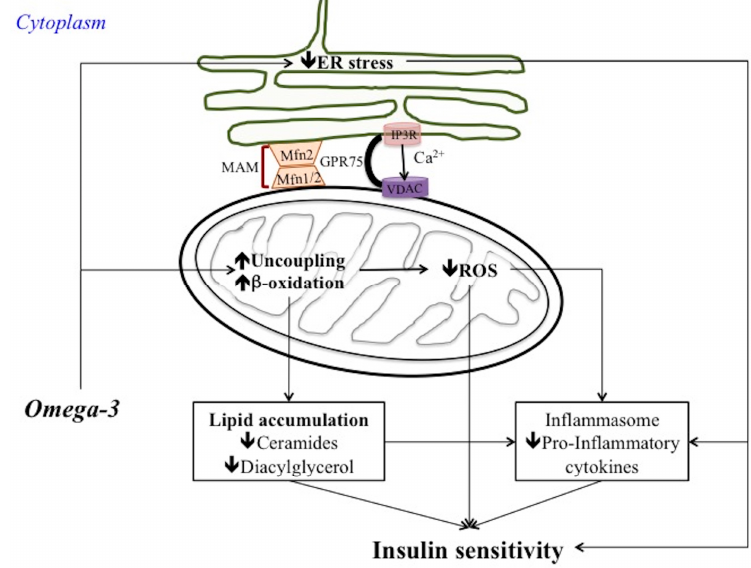
Figure 2. Proposal mechanism of omega 3 PUFA effects on insulin sensitivity. Omega-3 PUFA